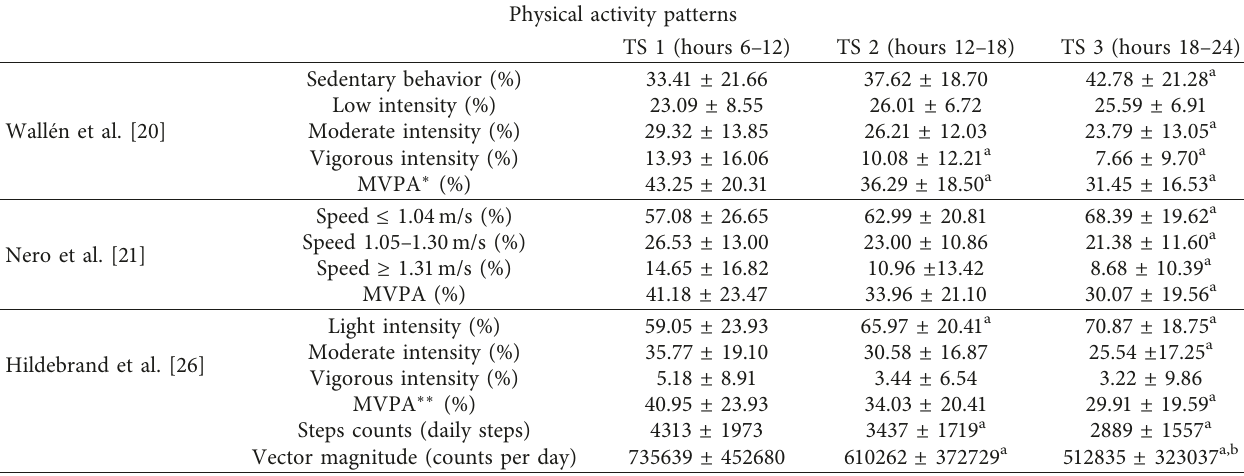
Table 2: Physical activity patterns for the morning, afternoon, and evening time slots calculated as means of the 3-month monitoring period.